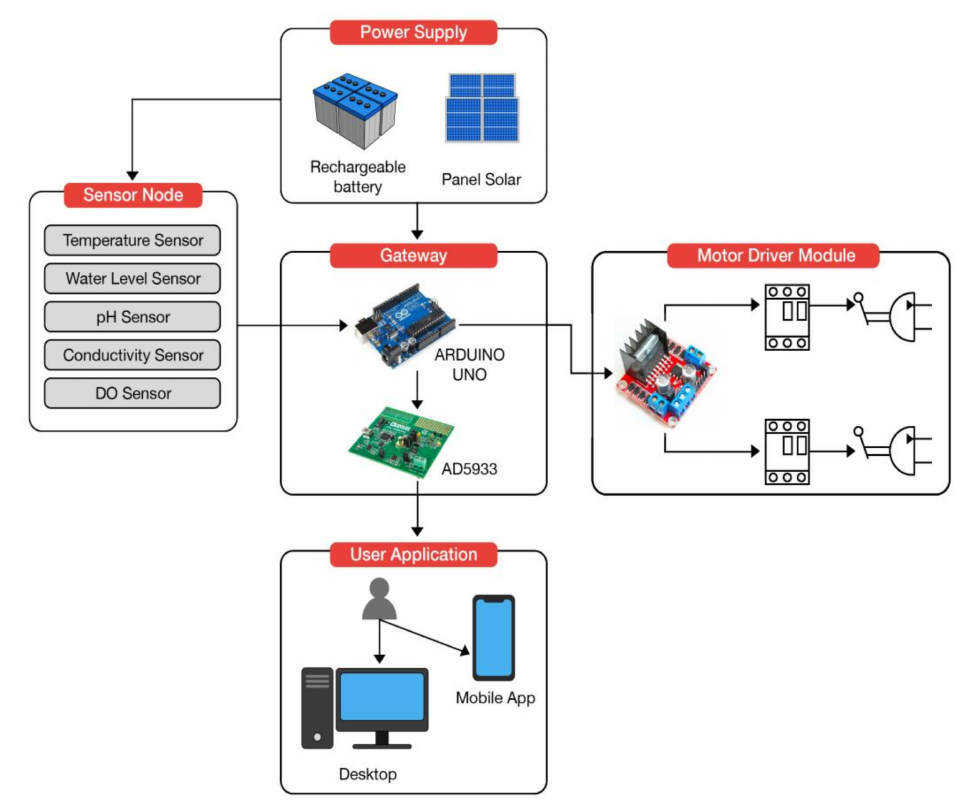
Figure 4. IoT monitoring water quality system block